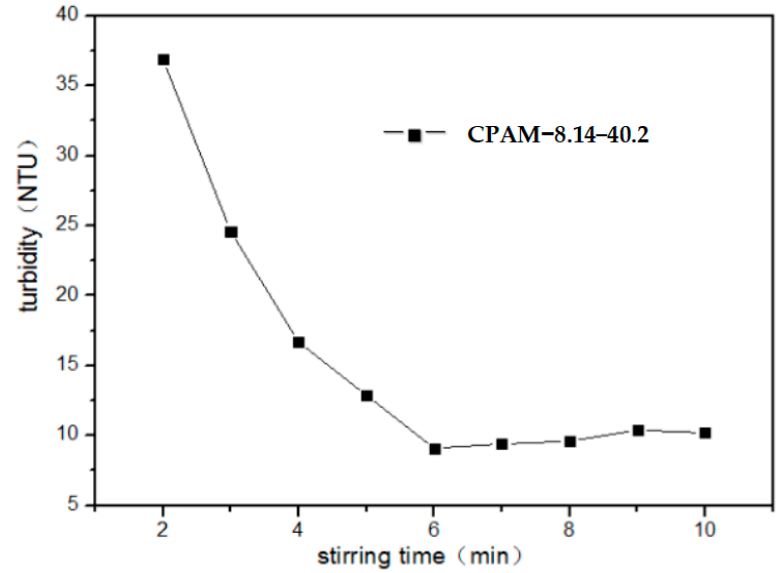
Figure 5. Impact of the stirring time on CPAM flocculation performance.